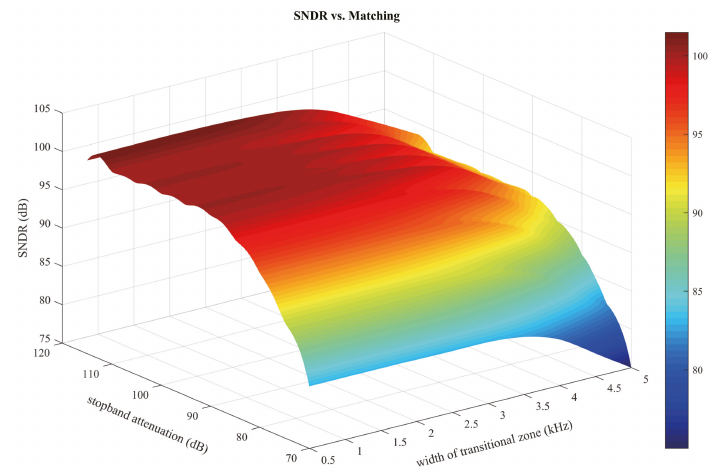
Figure 3. Simulation results indicating tendencies between signal to noise and distortion ratio (SNDR) and matching.